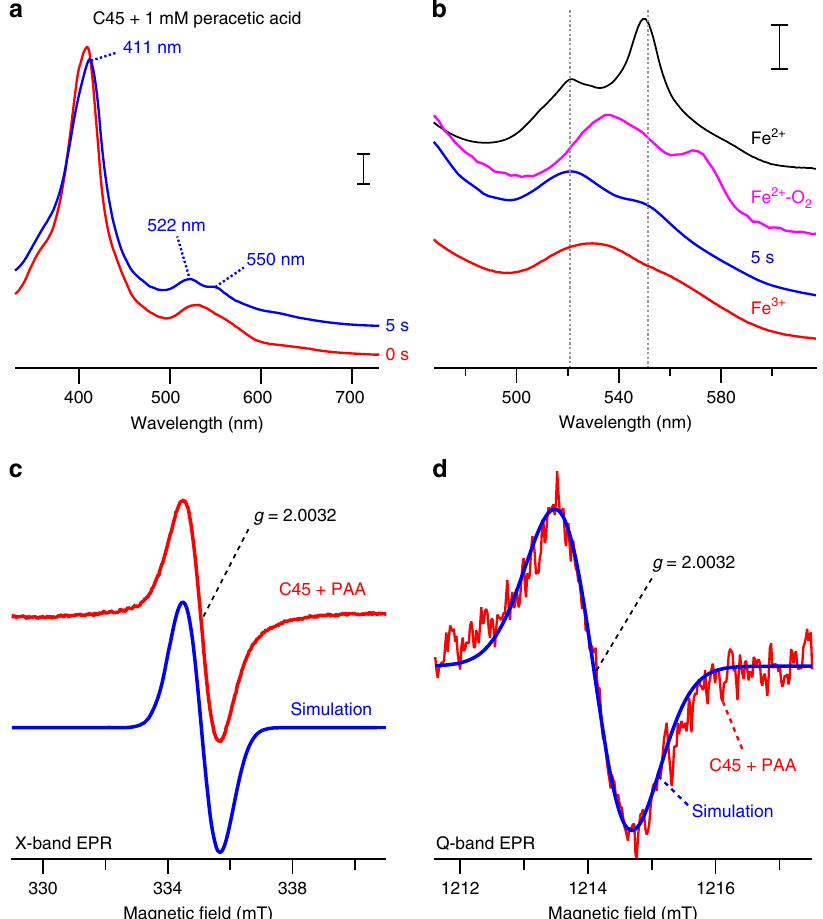
Fig. 4 Isolation of high-valent oxo-iron species in a CTM. a , b UV/visible spectra of ferric C45 ( red ) and peracetic acid-treated C45 ( blue ) obtained by rapid mixing experiments in a stopped- fl ow spectrophotometer. Ferrous ( black ), Ferric ( red ), and oxyferrous C45 ( magenta ) spectra are displayed for comparison. The putative C45 compound I species in a , b were generated by mixing 2 mM peracetic acid with 20 μ M ferric C45 in 100 mM KCl, 20 mM CHES, pH 8.58. Scale bars represent optical densities of 0.05 ( a ) and 0.02 ( b ). c X-band cw-EPR spectrum of C45 mixed with peracetic acid ( red ) indicates the formation of a radical species with g = 2.0032. Simulated data of a tryptophan radical species within C45 are presented in blue . Spectra were obtained by mixing 1 mM peracetic acid with C45 (700 μ M) in 100 mM KCl, 20 mM CHES, pH 8.58. Experimental conditions: EPR microwave frequency = 9.3933 GHz, microwave power = 1 mW, modulation amplitude = 0.3 mT, temperature = 12 K. d Q-band cw-EPR spectrum of C45 mixed with peracetic acid ( red , conditions as for the X-band EPR data) and simulated data of a tryptophan radical species in C45 are presented in blue . The lack of observable g-anisotropy of the radical signal indicates the presence of an amino acid side chain-based radical species. Experimental conditions: EPR microwave frequency = 34.027 GHz, microwave power = 3 μ W, modulation amplitude = 0.3 mT, temperature =